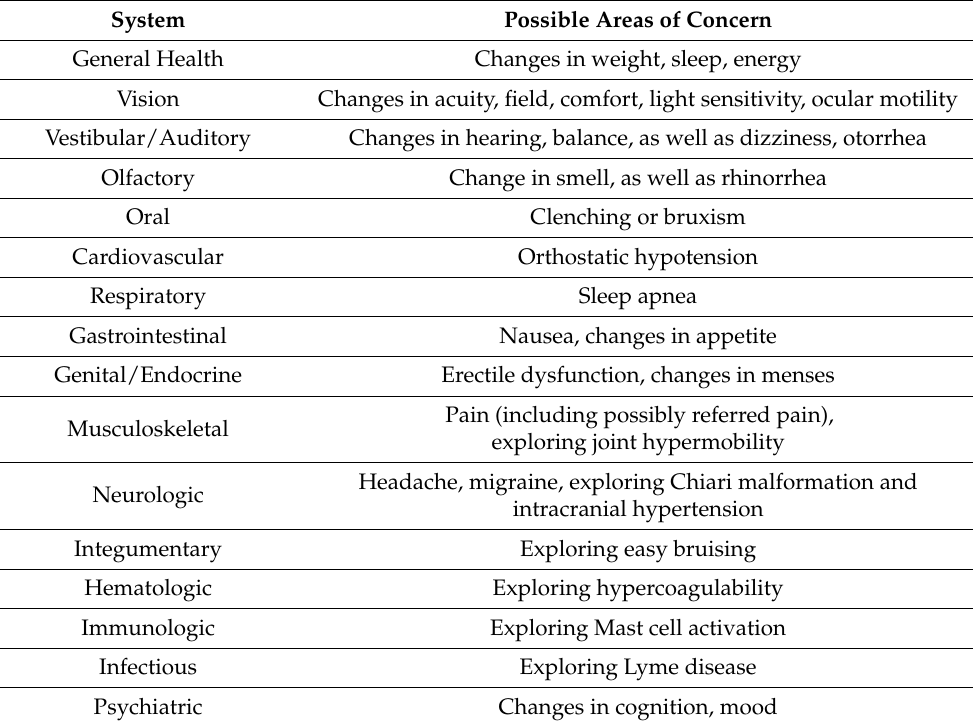
Table 1. Topics to Explore when Performing the Review of